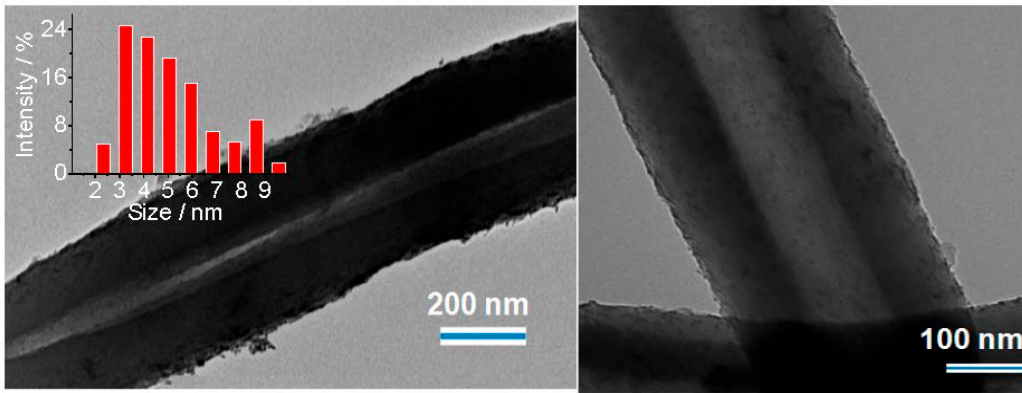
Figure 8. TEM of Pd/PP-3 after third catalytic cycle is over.